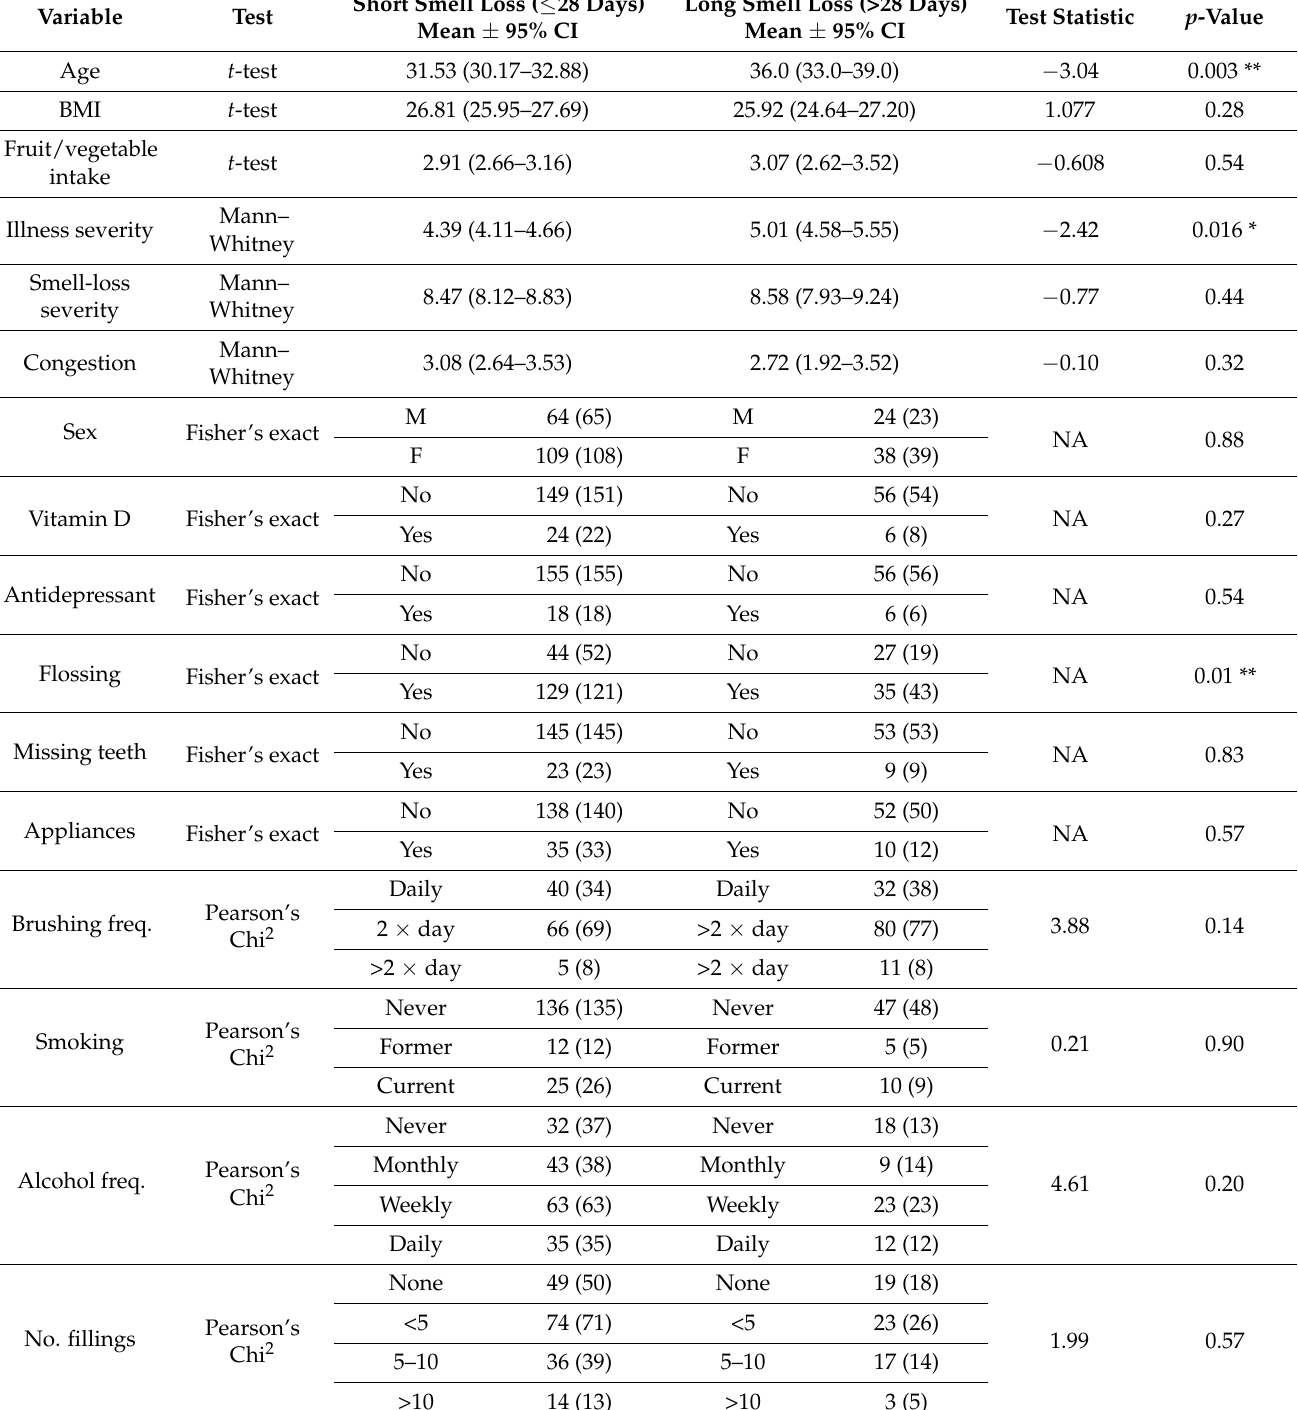
Table 1. Comparison of short ( ≤ 28 days) and long (>28 days) smell